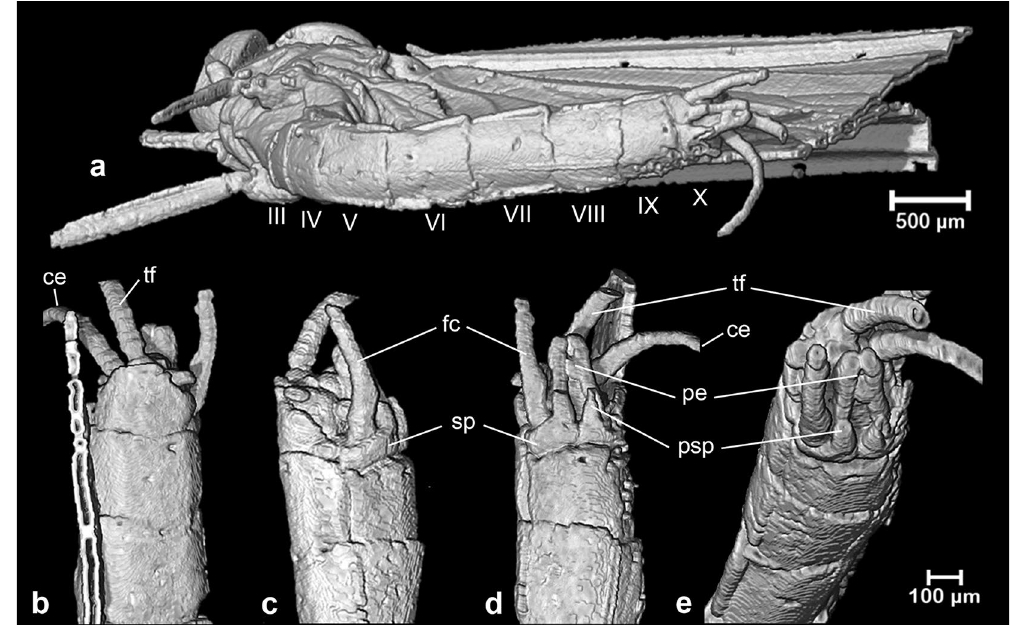
Figure 5. Micro-CT volume-rendered images of Calliarcys antiquus sp. nov. , holotype, male imago; Eocene Baltic amber; BB 2515 [SMNS coll.]; ( a ) body in ventral view; ( b ) tip of abdomen in dorsal view; ( c ) tip of abdomen with genitalia in left lateral view; ( d ) tip of abdomen with genitalia in ventral view; ( e ) tip of abdomen with genitalia in ventrocaudal view; ce—cercus; tf—paracercus; III-X—abdominal segments; fc—forceps; sp— styliger plate; pe—penes; psp—projection of styliger